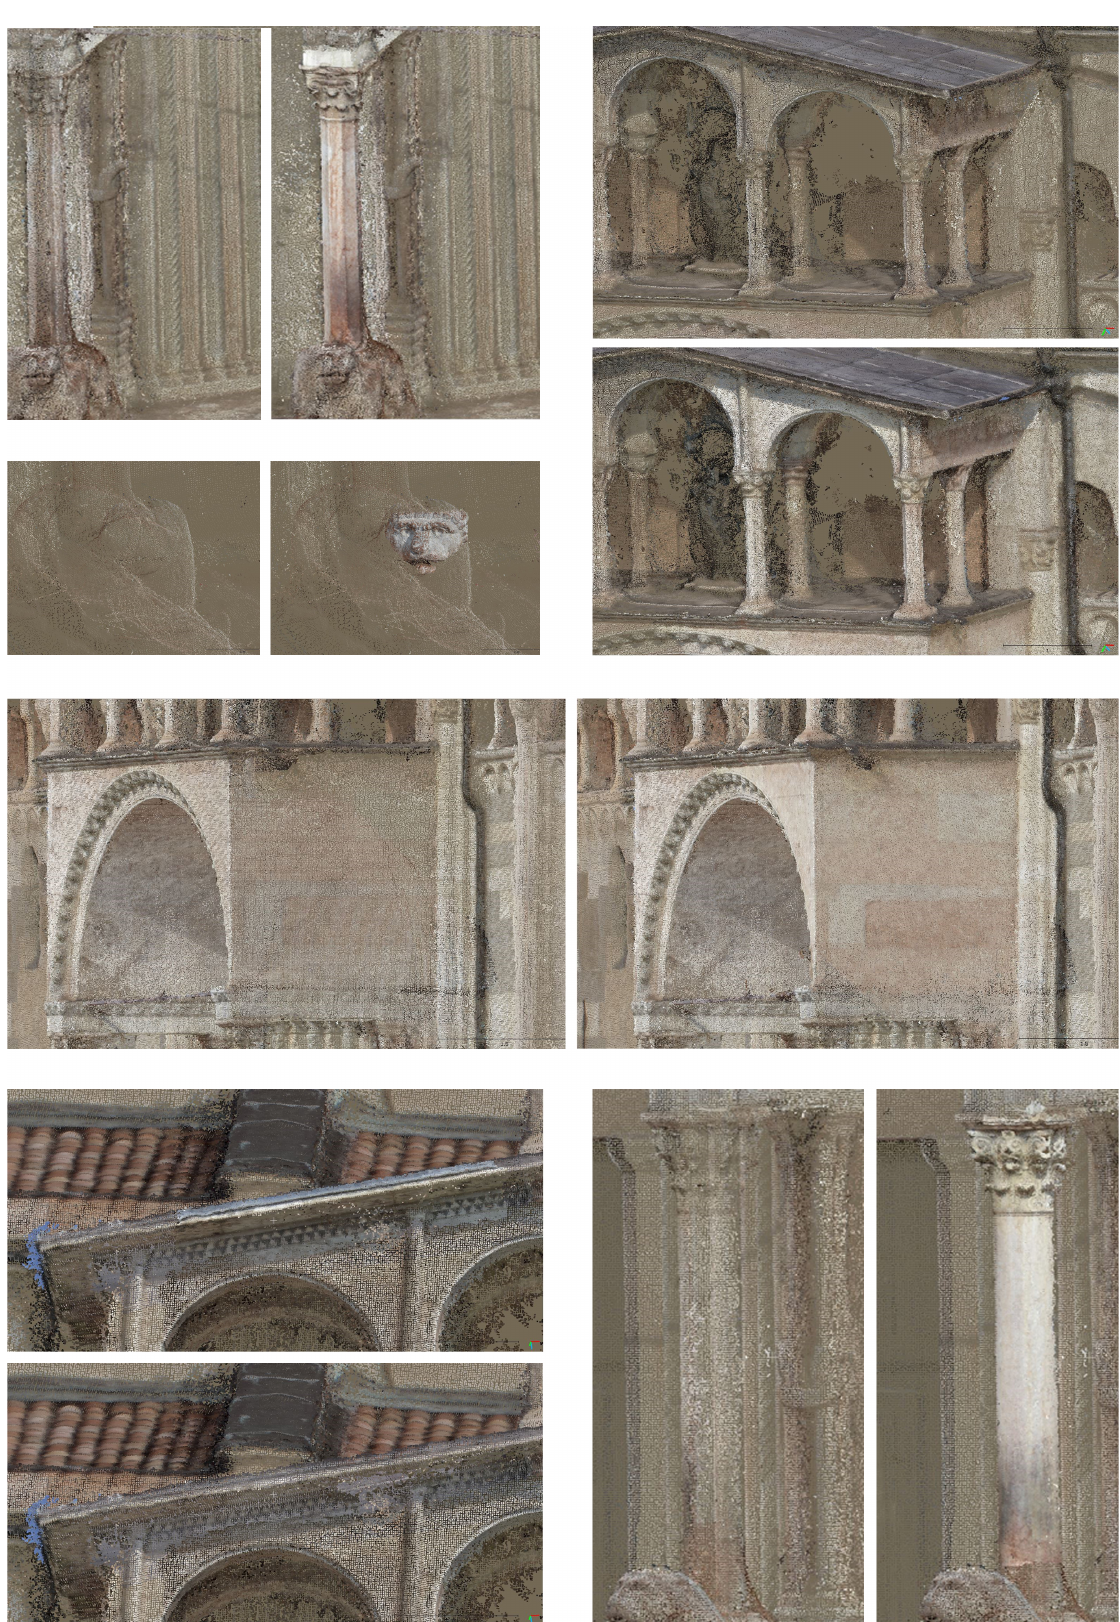
Figure 8: Single-cluster visual evaluation of the improvements in the dense point clouds obtained after the filtering procedure. Dense point clouds computed for each cluster show a general improvement of results, with much denser point clouds, less noise and a higher definition of the architectural